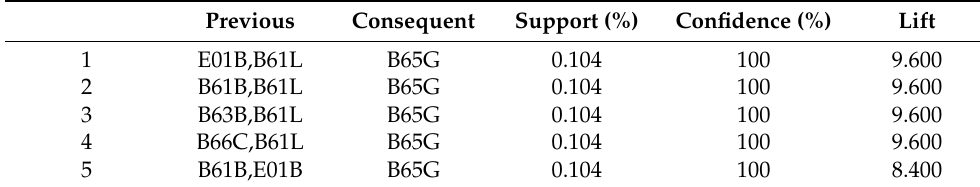
Table 7. The association rules for the 10th patent